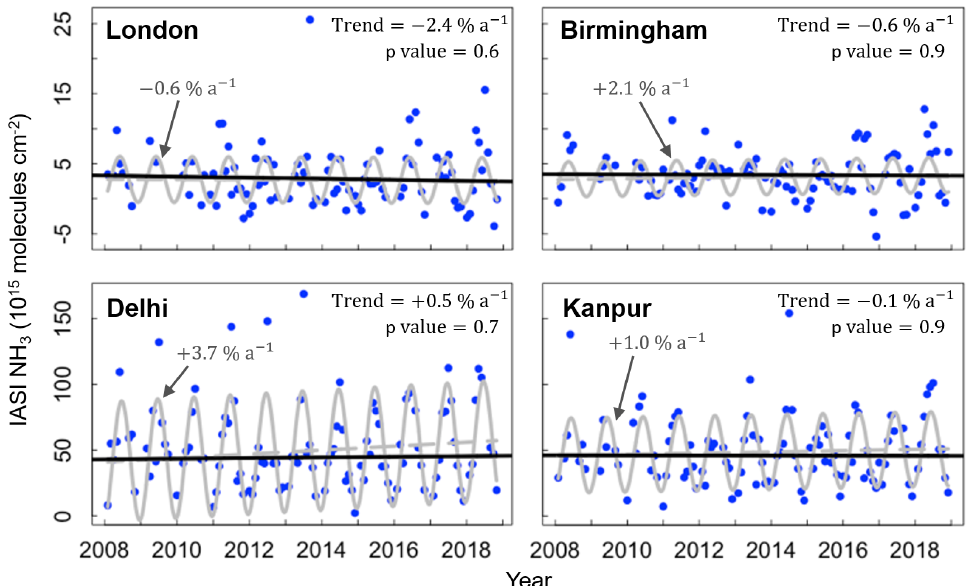
Figure 8. Time series of IASI NH 3 in 2008–2018 for London, Birmingham, Delhi, and Kanpur. Points are city-average monthly means. Black lines are trends obtained with the Theil–Sen single median estimator. The grey lines are the fit (solid) and trend component ( B ) (dashed) obtained with Eq. (1). Values inset are annual trends and p values for the Theil–Sen fit (in black) and annual trends obtained with Eq. (1) (grey). Trend errors (not shown) exceed ± 150% in all